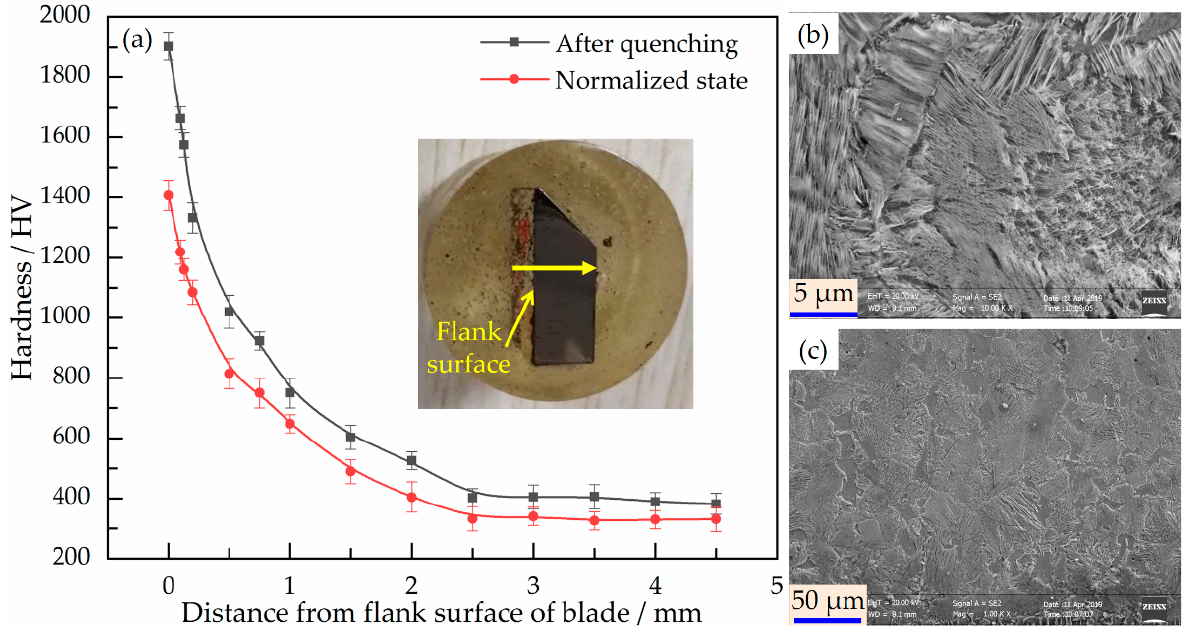
Figure 2. Hardness distribution for carbon-nitron-boronized blades with rare earth catalysis and the microstructure of transition region: ( a ) hardness gradient distribution diagram; ( b ) quenched microstructure; ( c ) normalized microstructure.